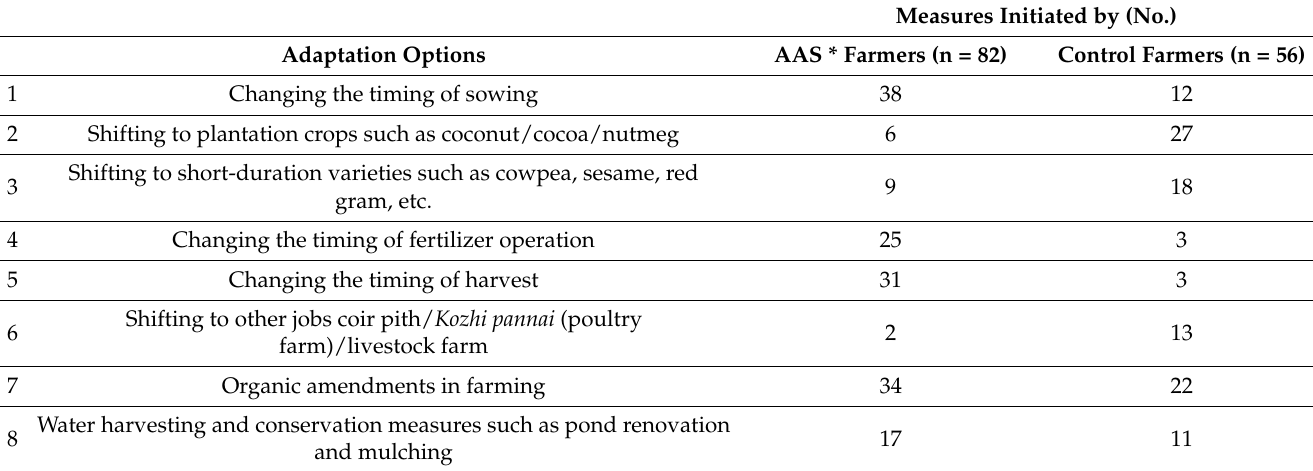
Table 5. Adaptation measures adopted by the maize